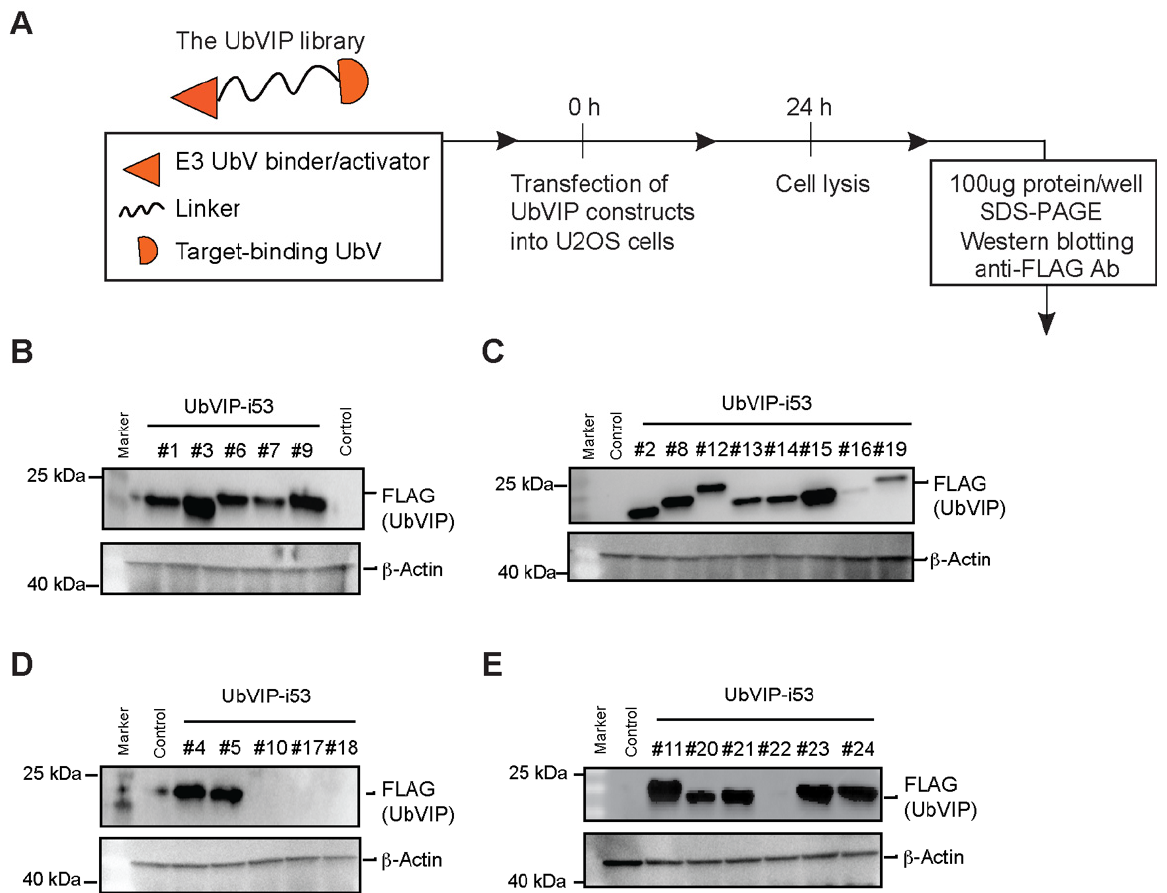
Figure 2. Cellular expression analysis of the Ubiquitin Variant Induced Proximity (UbVIP) library targeting 53BP1. ( A ) Pipeline for determining expression of UbVIP in mammalian cells. U2OS cells were transfected with the UbVIP constructs, and cells lysed after 24 h and whole cell lysates were subjected to SDS-PAGE and immunoblotting using an antibody against the FLAG tag. ( B – E ) Western blot analysis of UbVIP expressed in U2OS cells compared to untransfected control. The identifier numbers are as described in Table 1.